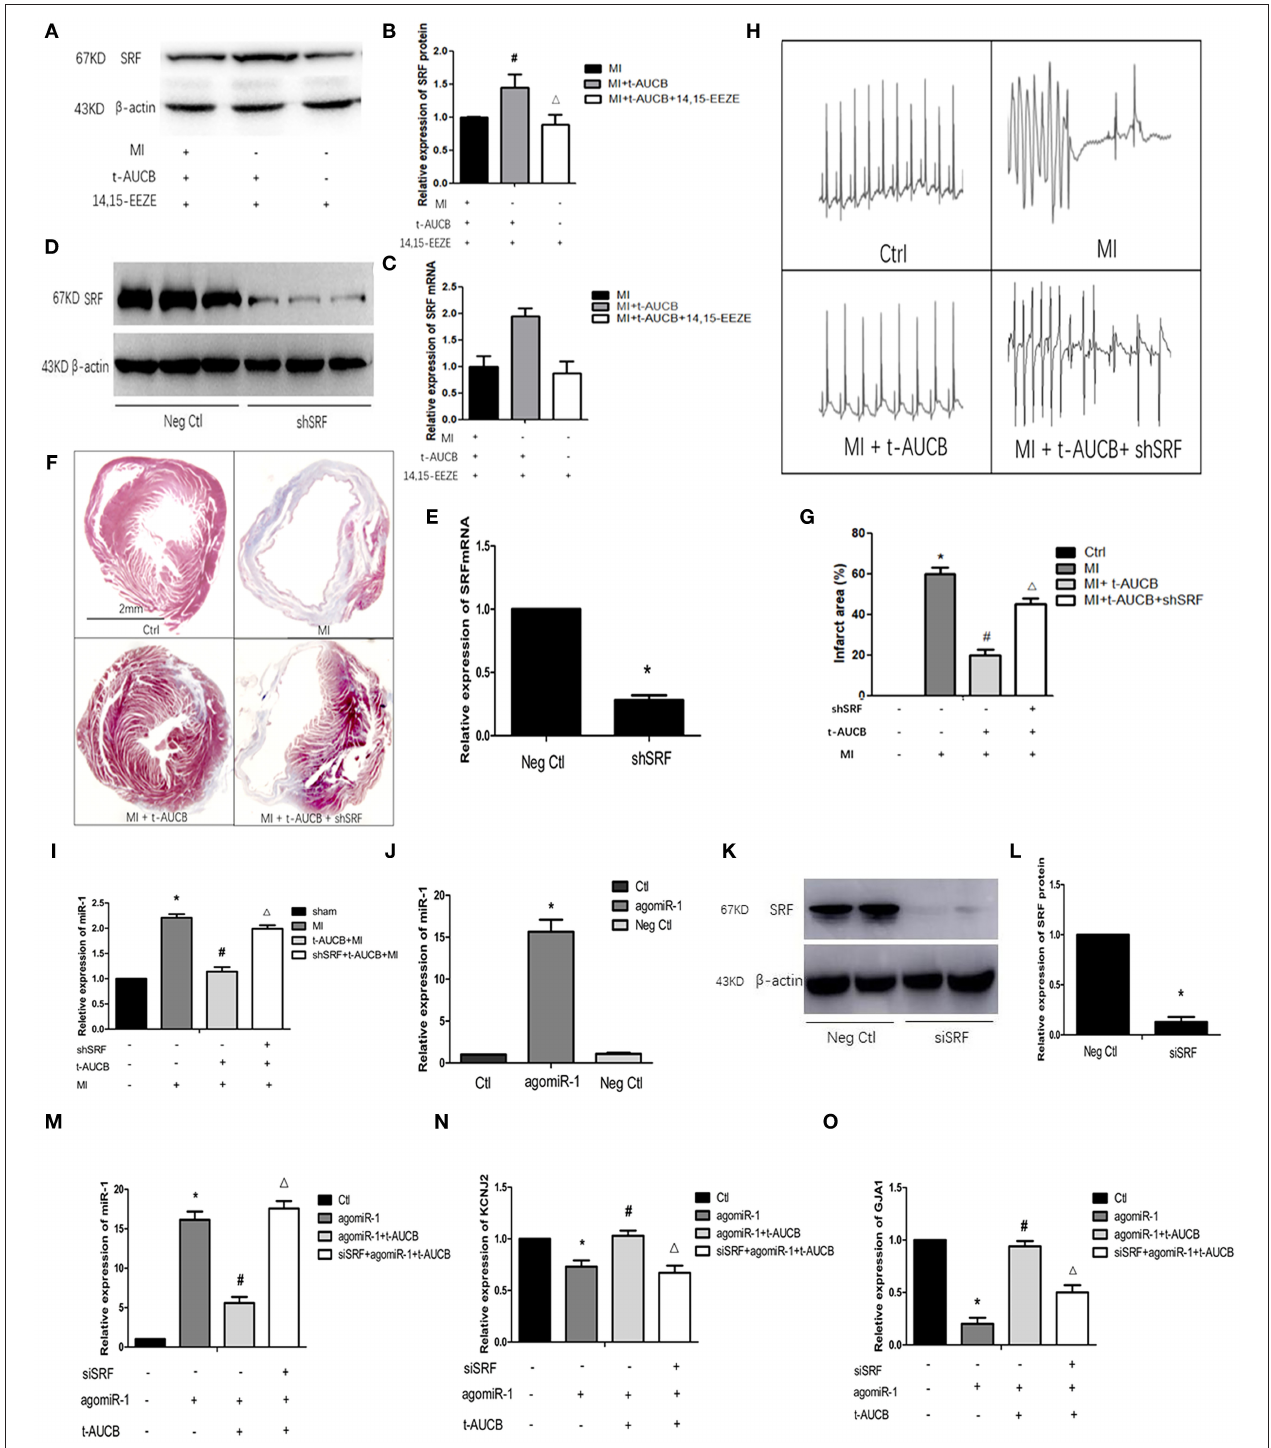
FIGURE 1 | T-AUCB negatively regulates miR-1 through SRF. MicrONTM mmu-miR-1a-3p croRNA-1 (agomiR-1), serum response factor (SRF), small interfering RNA (siSRF), and t-AUCB were used to treat mouse cardiomyocytes, and then SRF, microRNA-1 (miR-1), and its target genes were detected. On the other hand, SRF small hairpin (shSRF) RNA sequence adenovirus, t-AUCB, and 14,15-EEZE were used to treat mice with myocardial infarction (MI), and the changes of MI area, ECG, SRF, and miR-1 were checked. (A) Grayscale images of SRF after 14,15-EEZE intervention ( n = 4). (B) Relative protein expressions of SRF ( n = 4). (C) Relative